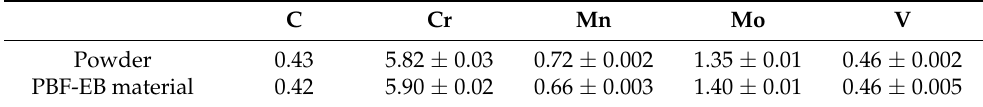
Table 3. Chemical composition of the X37CrMoV5-1 powder and PBF-EB specimen. All values in wt-%.